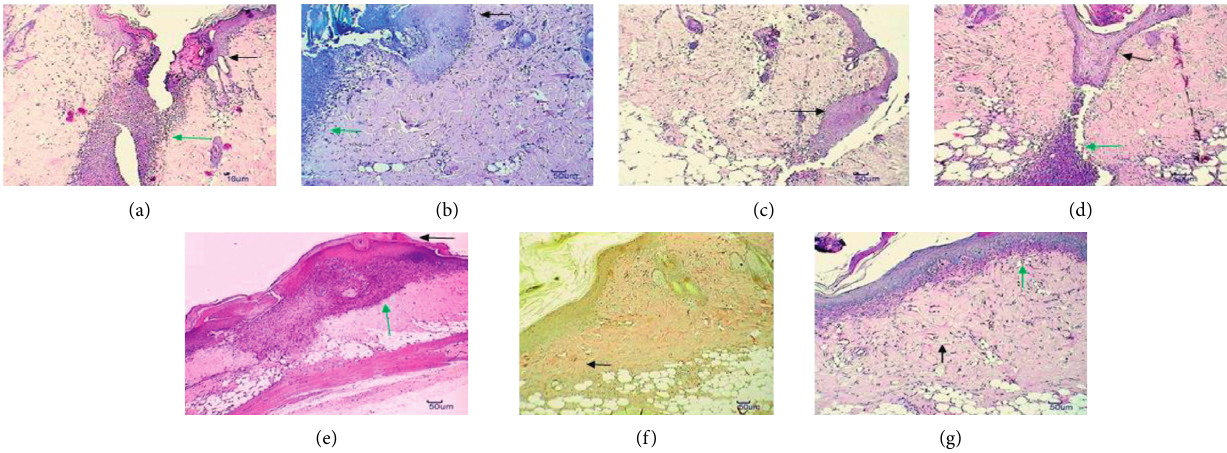
Figure 6: Histopathological indications on Prolene suture skin area sections. (a) 24Hrs—H and E 10x, necrosis of epidermal and dermal cells, severe neutrophilic infiltration. (b) 48hrs—Giemsa 10x, epithelial cell migration, severe neutrophilic infiltration. (c) 72hrs—H and E 10x, moderate amount of epidermal proliferation and thickening. (d) 96hrs—H and E 10x, epidermal layer thickening, mild granulation tissue formation. (e) 120hrs—H and E 10x, severe epidermal keratinization, moderate granulation tissue formation. (f) 144hrs—van Gieson 10x, diffuse fibroblast proliferation in the dermis. (g) 160hrs—PAS 10x, severe collagen production, maximal neovascularization in the dermis.